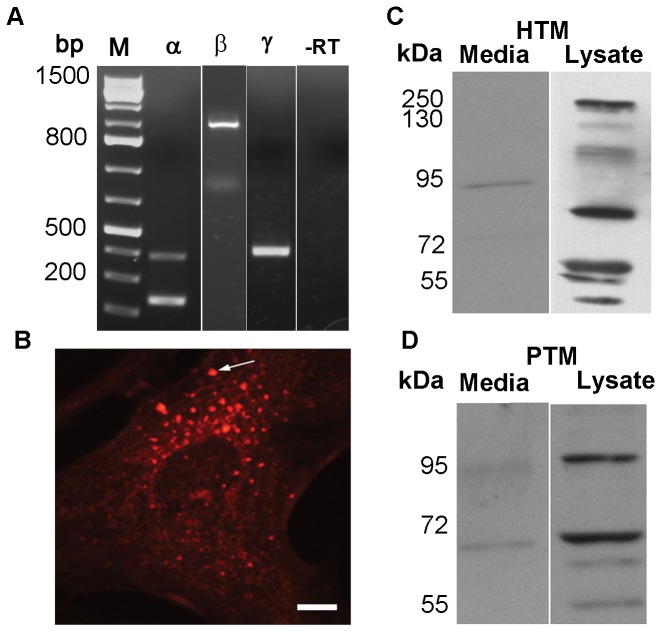
Expression and secretion of ATX by primary cultures of trabecular meshwork cells derived from human and porcine eyes.A. RT-PCR based amplification of total RNA derived from human TM cells confirmed expression of the α, β and γ variants of ATX. PCR products were sequenced to confirm identity. Similar observations were noted in TM cells from three different human donors. -RT represents negative controls run without reverse transcriptase. B. Immunofluorescence localization of ATX in primary cultures of human TM cells reveals a vesicular/punctate distribution, characteristic of a secretory protein. C and D. Human (C) and porcine (D) TM cell lysates (20 µg protein) and conditioned media from TM cells (10 µg protein) show the presence of various isoforms of ATX by immunoblot analysis. Bar: 10 µm.